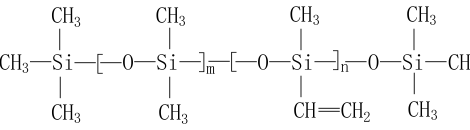
Figure 1. PMVS molecular structure diagram.